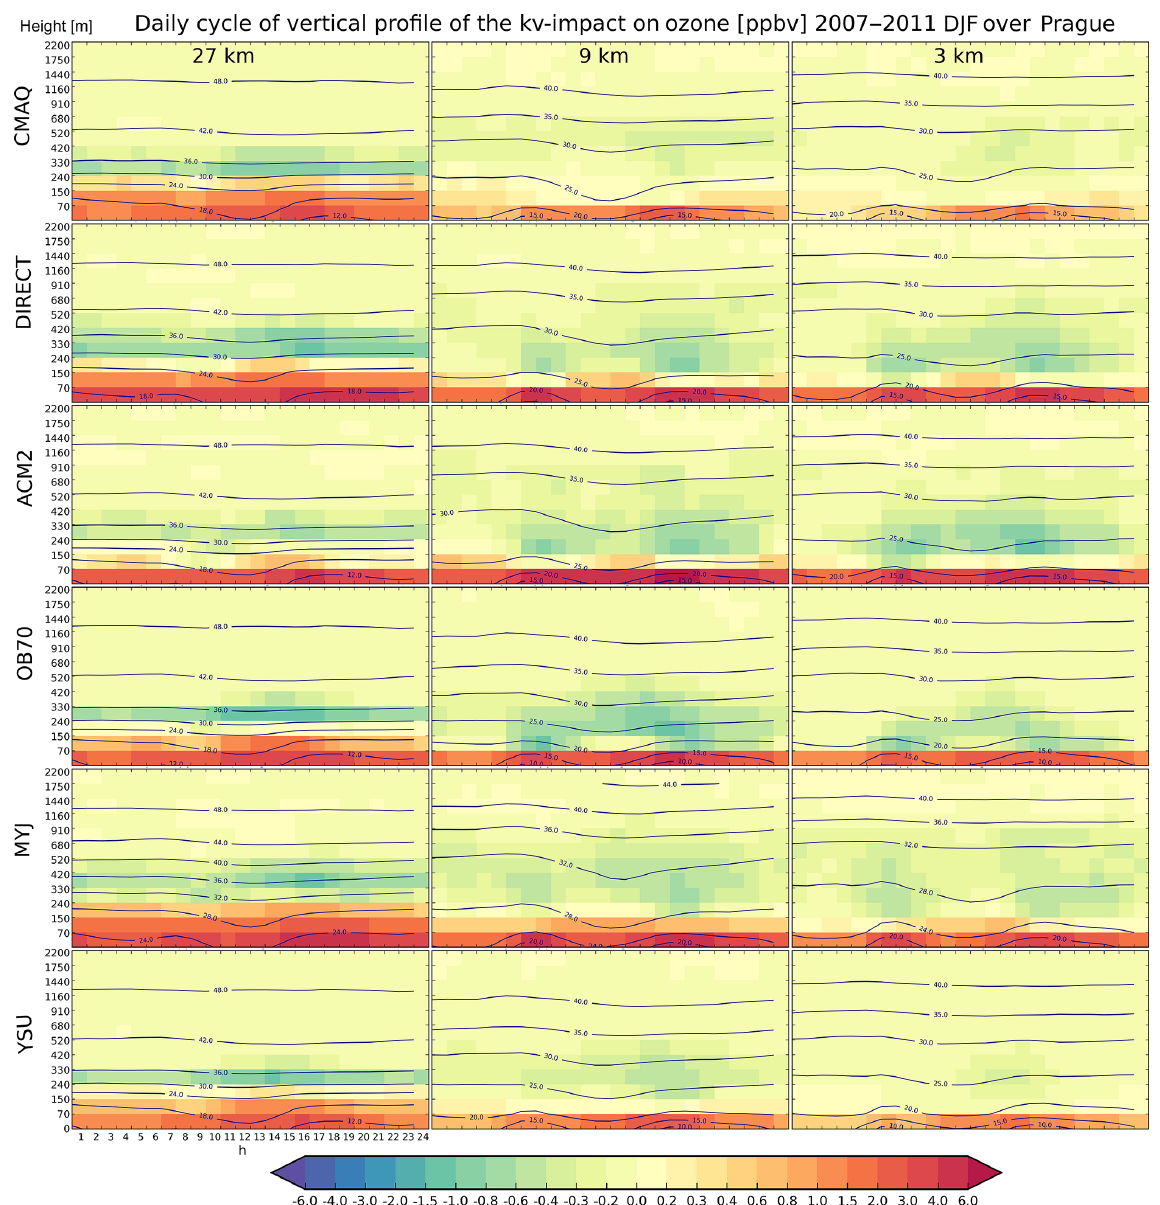
Figure 22. Same as Fig. 21 but for